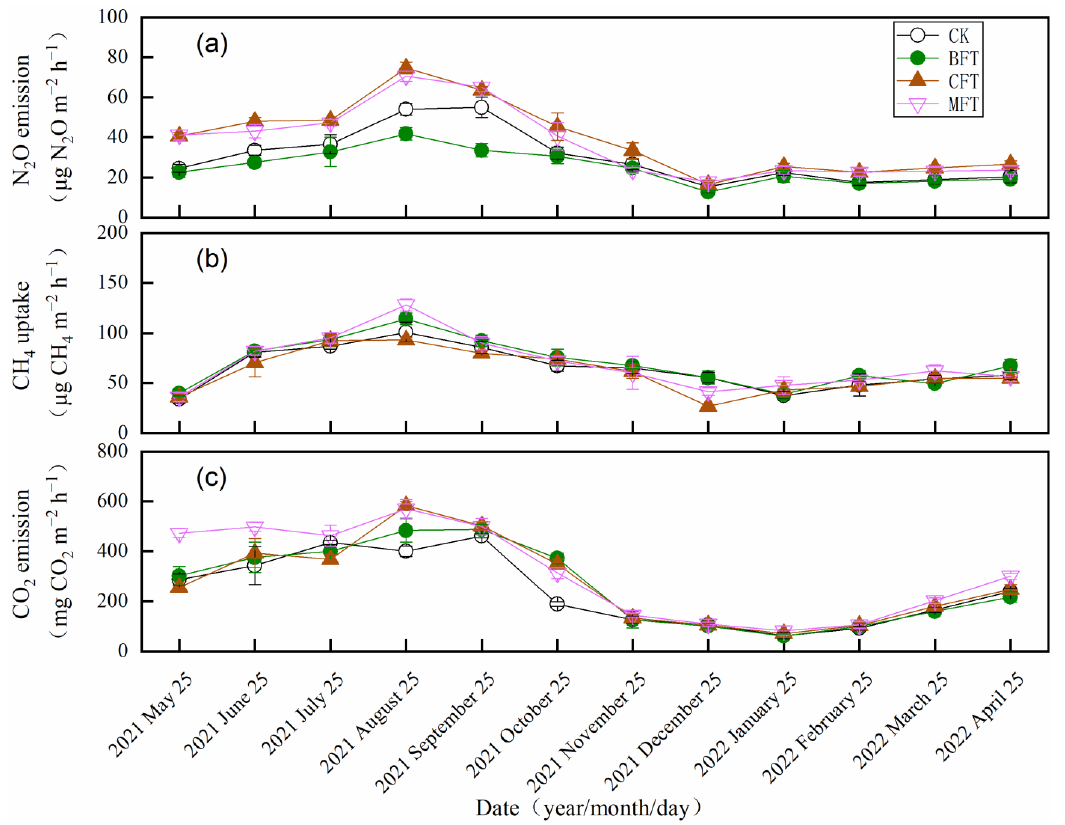
Figure 3. Effects of various fertilization strategies on soil ( a ) N 2 O emission ( b ) CH 4 uptake ( c ) CO 2 emission in the Pleioblastus amarus (Keng) Keng f. plantation. The standard deviation is indicated by vertical bars.